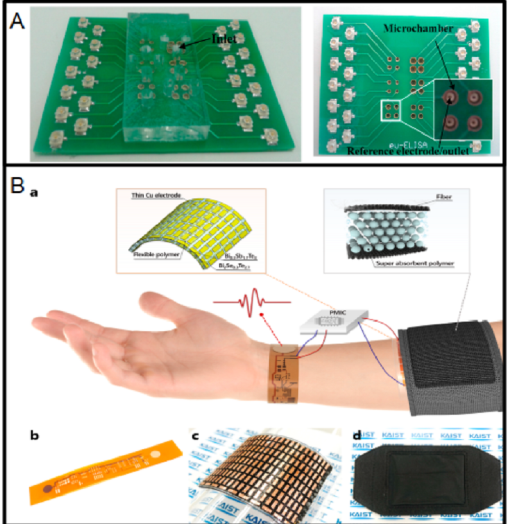
Figure 13. ( A ) Left: Lab-on-PCB integrating microfluidics and PCB microchambers and reference electrodes, right: two-layer PCB before the assembly of microfluidics, comprising microchambers in the top layer and PCB reference electrodes in the bottom layer (reprinted from [174], copyright (2015), Creative Commons License). ( B ) a: schematic diagram of a wearable electrocardiography system, b: flexible electrocardiography module, c: wearable thermoelectric generator, d: polymer-based flexi- ble heat sink (reprinted with permission from [179], copyright (2011), American Chemical